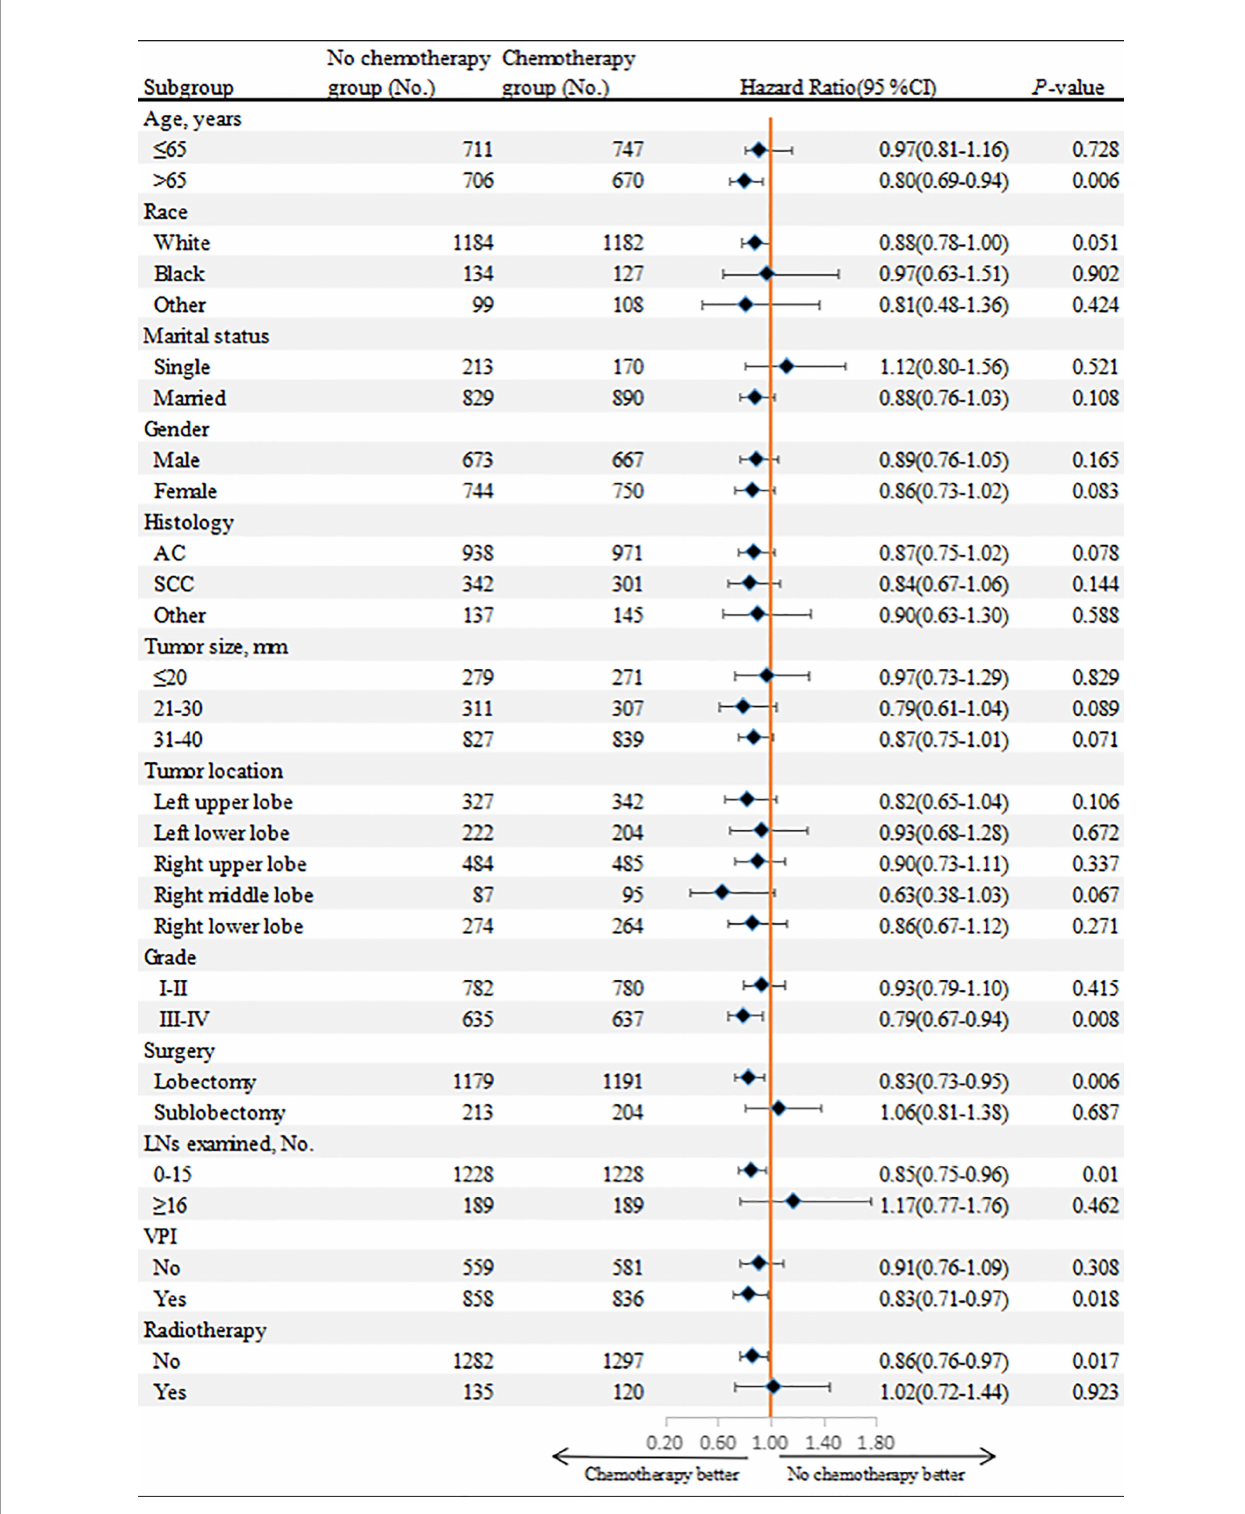
FIGURE 6 | Overall survival comparisons between chemotherapy and non-chemotherapy groups according to patient characteristics in the matched cohort.